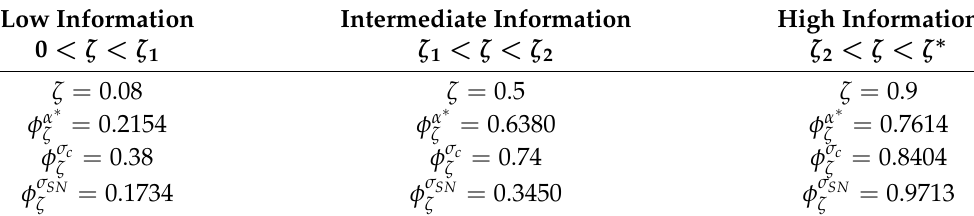
Table 1. Sensitivity indices of the thresholds α ∗ , σ c and σ SN for three different levels of information: low, intermediate and high. The numerical values of the system parameters used for the computations are: µ = 0.05; ρ = 0.25; λ = 0.02; p = 0.7; q = 0.8. Here ζ ∗ = 0.9375; ζ 1 = 0.1135; ζ 2 = 0.8861. Low Information Intermediate